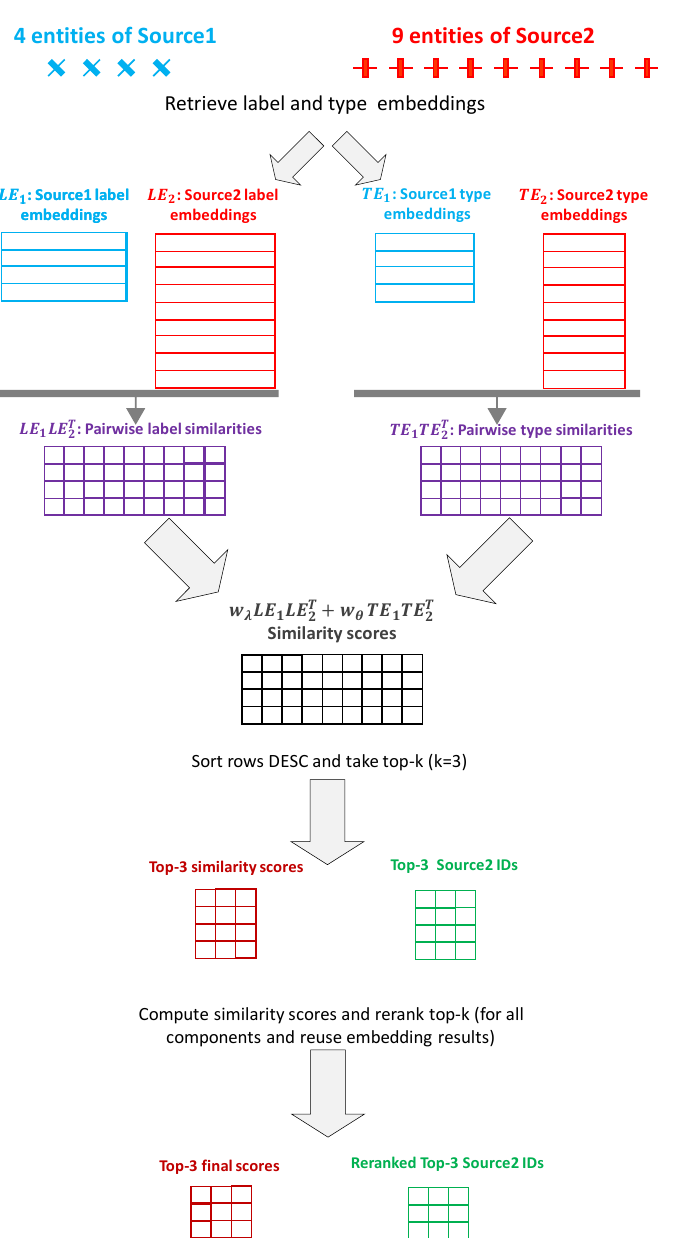
Figure 5. Scoring process with use of label and type embeddings for early pruning of alignment